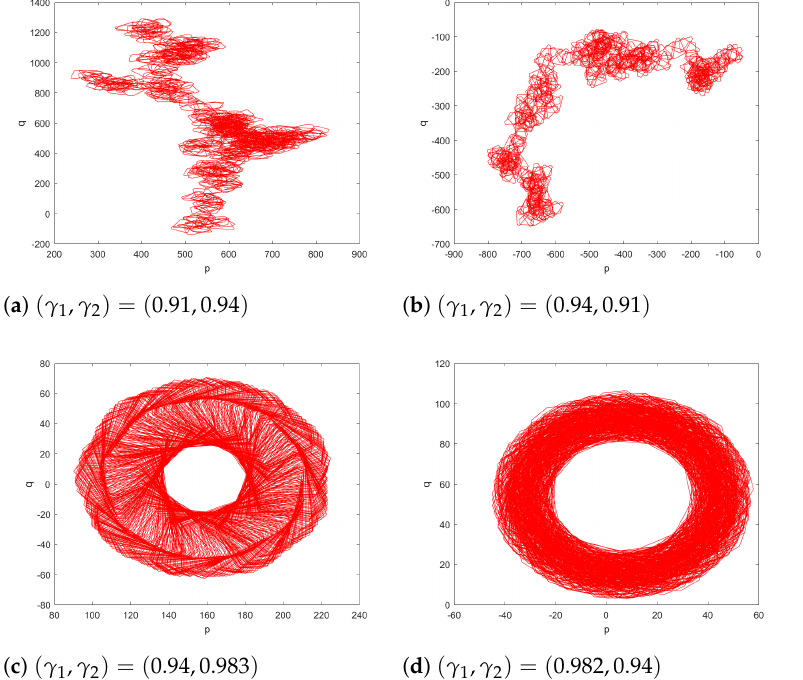
Figure 13. The p – q trajectories of the 0 − 1 test of the fractional discrete SIR epidemic model (11) with incommensurate orders ( γ 1 , γ 2 ).